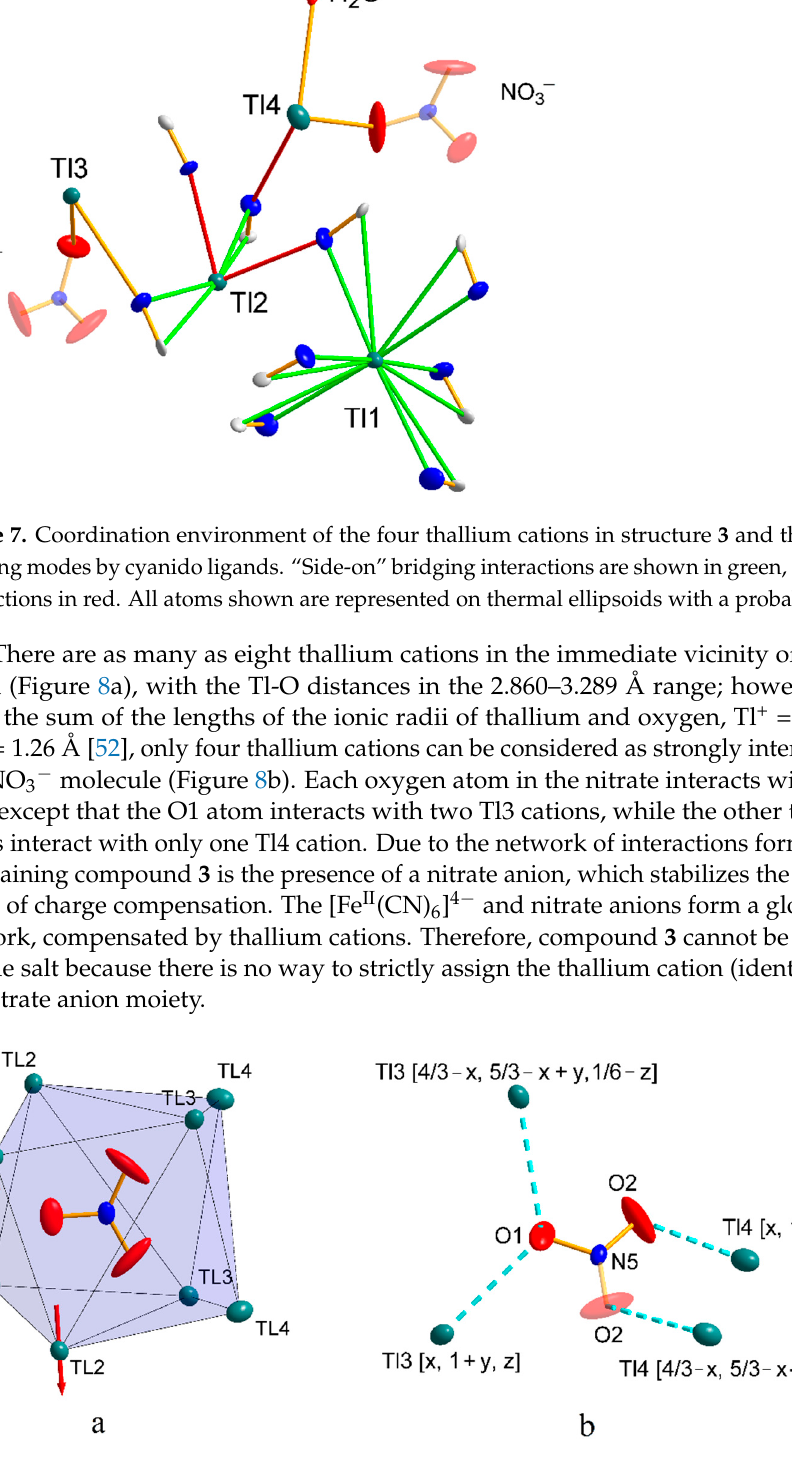
Figure 8. ( a ) Geometry of a slightly distorted antiprism square surrounding a nitrate anion formed by eight thallium cations. Red arrows indicate the direction of polyhedral deformation. ( b ) Strong nitrate anion interactions with thallium cations.